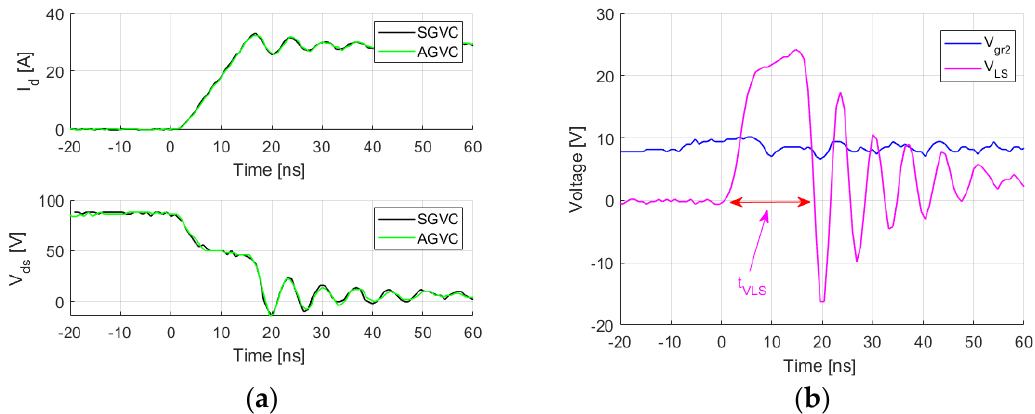
Figure 16. Experimental waveform of the main voltage and current using the proposed closed-loop active gate voltage circuit (AGVC) and standard gate voltage control (SGVC) (I d = 28 A, L s = 2 nH), ( a ) V ds and I d , ( b ) V Ls , V gr2 , V gs of AGVC and V gs of SGVC.